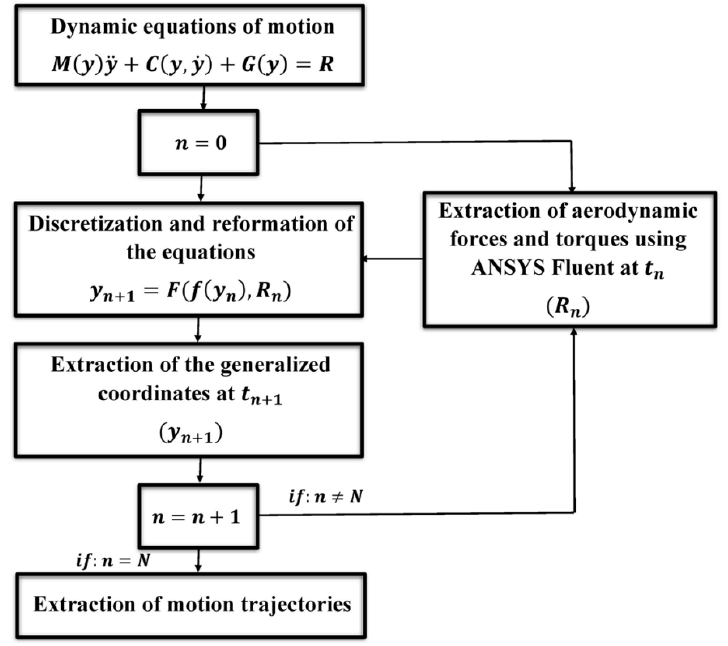
Figure 1. The general algorithm of problem-solving.